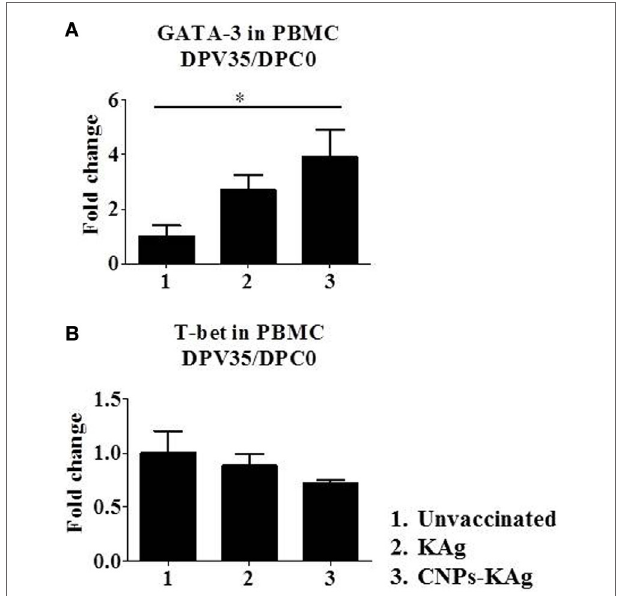
FigUre 4 | Expression of T helper 1 (Th1) and T helper 2 (Th2) response inducing specific transcription factors after prime-boost vaccination in pigs. The expression of (a) Th2 transcription factor GATA-3 and (B) Th1 transcription factor T-bet in peripheral blood mononuclear cells of pigs at day post-vaccination (DPV) 35/day post-challenge (DPC) 0 were determined by quantitative reverse transcription PCR (qRT-PCR). Data represent the mean value of three to five pigs ± SEM. Statistical analysis was carried out using Kruskal–Wallis test followed by Dunn’s post hoc test. Asterisk refers to the statistical significant difference between the indicated two pig groups. * p <